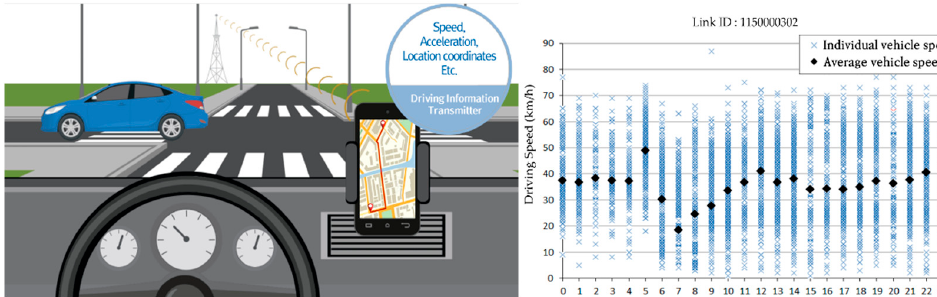
Figure 4. Real-time driving information collection using cell phone data transmission.